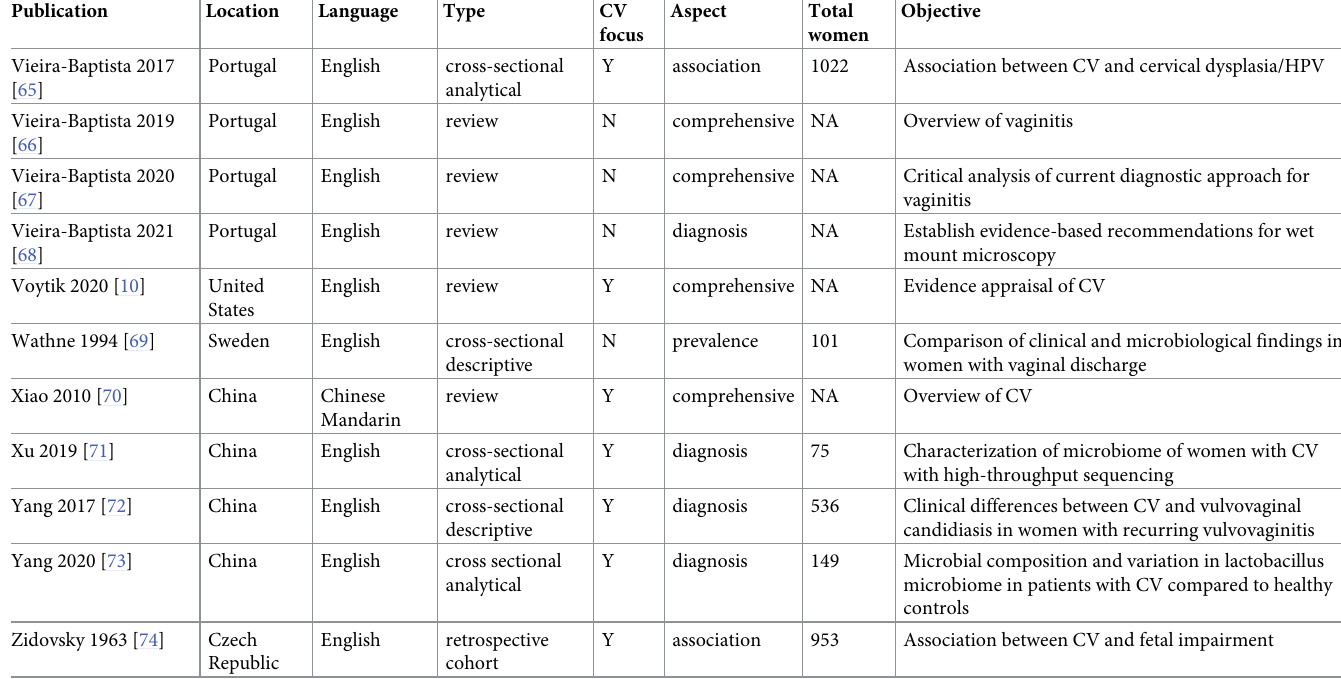
Twenty-two of the 32 non-review studies (69%) provided diagnostic criteria. Table 3 summa- rizes the diagnostic criteria used in the studies. Nine of these studies (41%) focused primarily on microbiology results for diagnosis (lacto- bacilli and cytolysis), while the other 12 studies (55%) used Cibley criteria or a variant of Cibley criteria, and 1 study (5%) did not indicate. Two studies (9%) provided scores/observations for diagnosing CV. Specifically, Hu et al. [39] was based on quantity of lactobacilli and cytolysis;